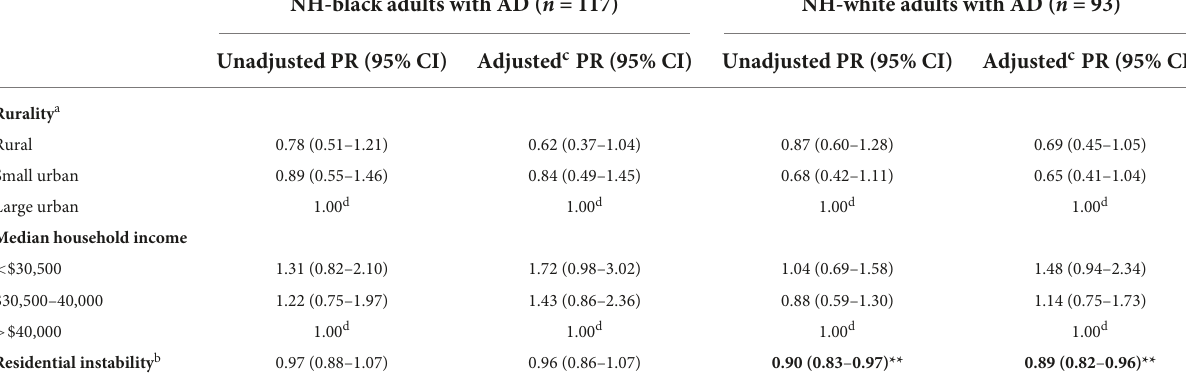
TABLE 4 Prevalence ratios of total neuropsychiatric symptoms by neighborhood characteristics among non-Hispanic black and non-Hispanic white older adults,